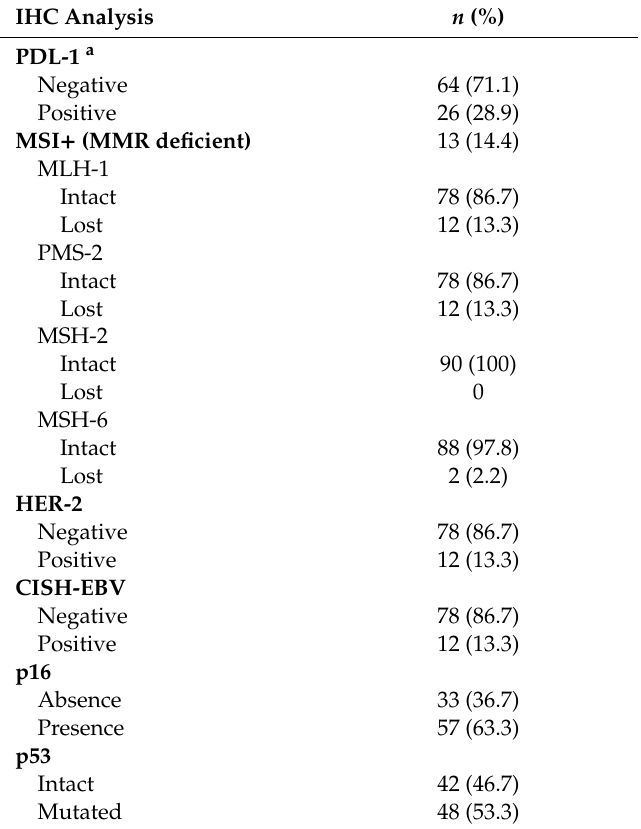
Table 2. Immunohistochemistry tumor analysis ( n =